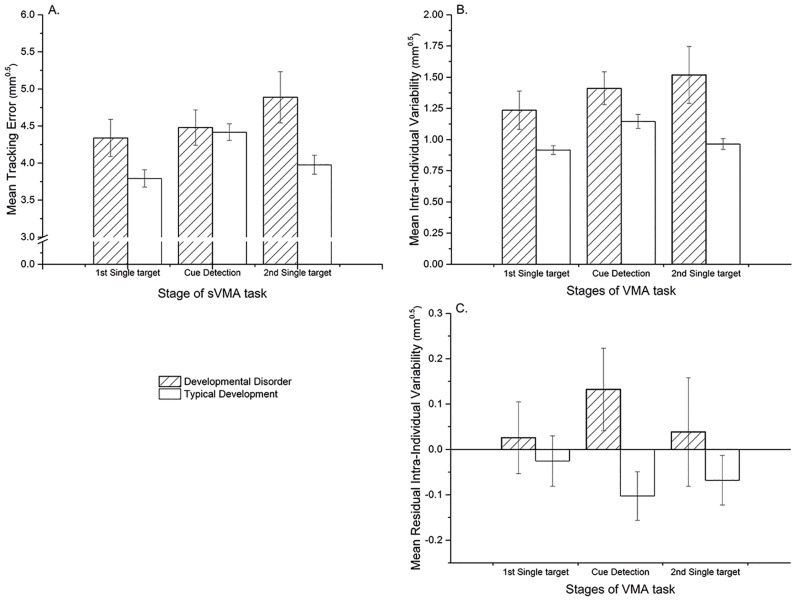
Bar graphs illustrating the significant interaction between group and VMA task stage for tracking outcomes in Experiment 2. Panel A: tracking error; Panel B: intra-individual variability; Panel C: residual intra-individual variability. Error bars represent 95% confidence intervals.